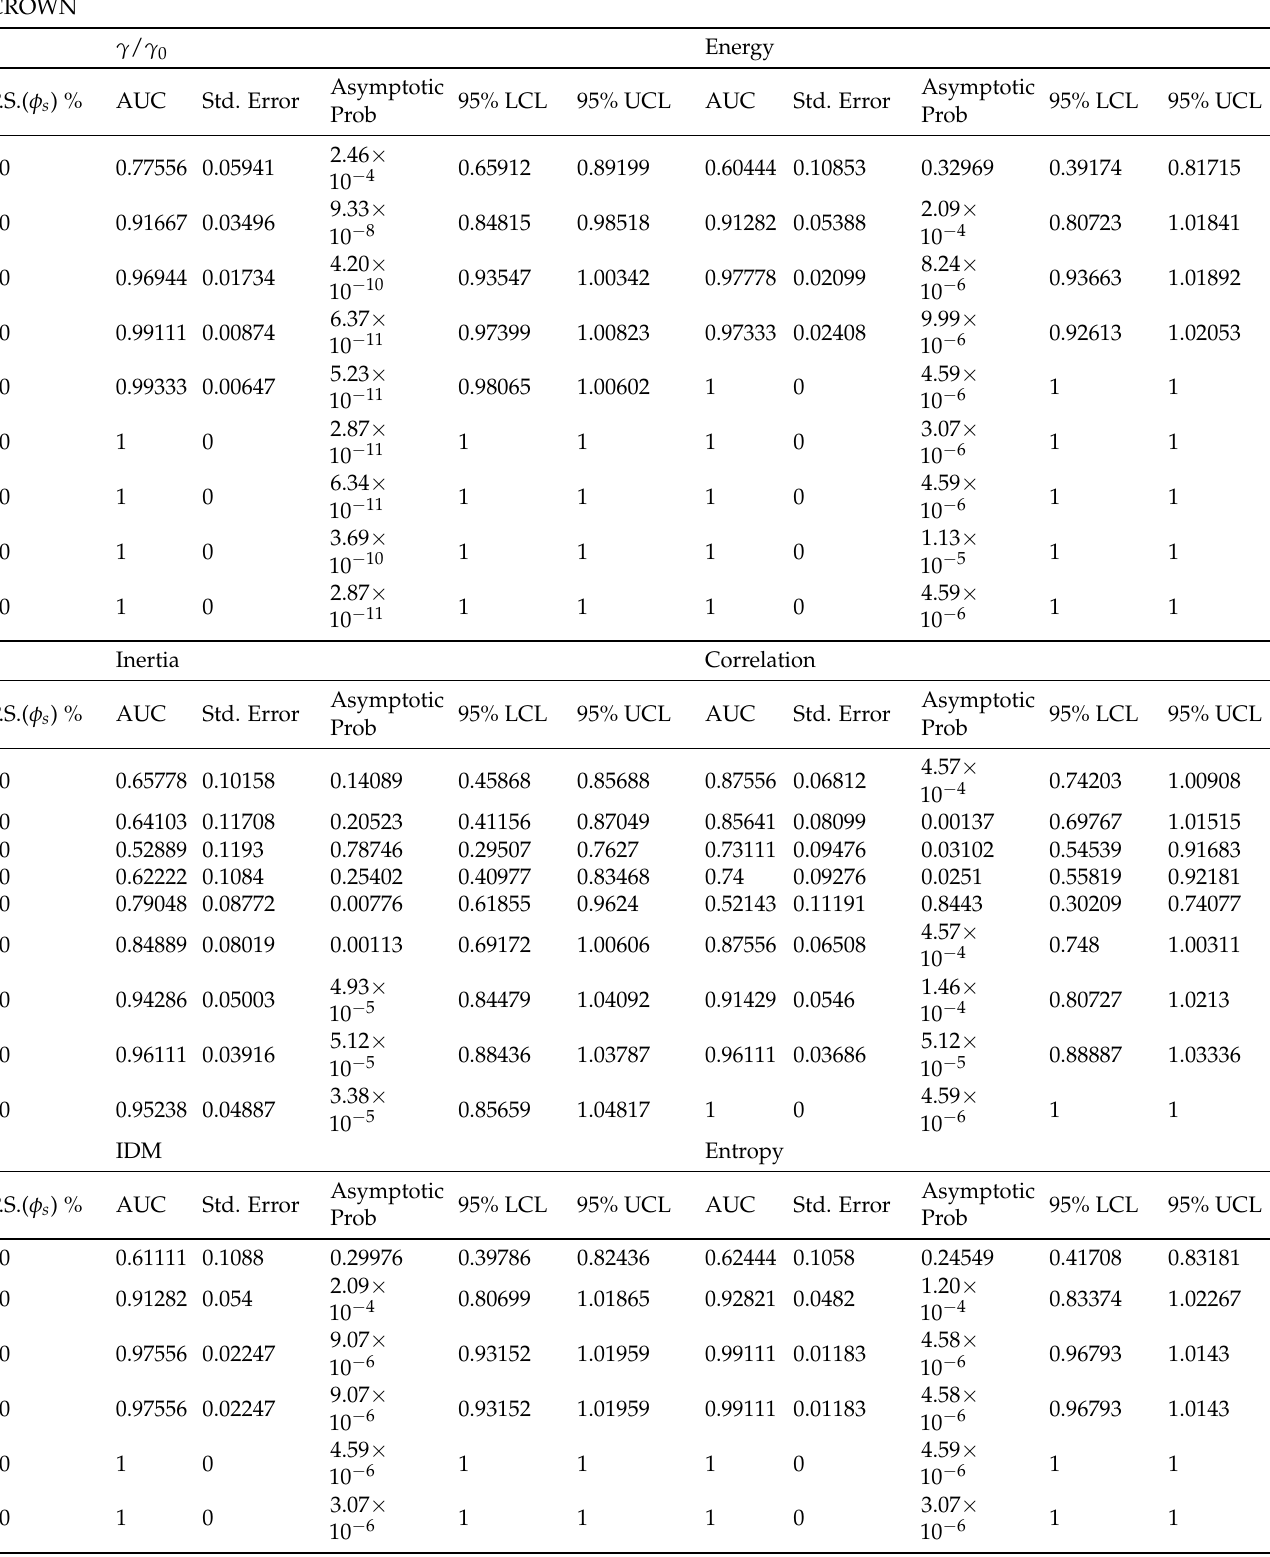
Table 1. Receiver Operated Characteristic (ROC) curves based on texture parameters estimated on different regions of Methotrexate/NaCl stains. Ps = water content (%). Error = standard error. Asym. prob.: asymptotic probability. LCL: the lower confidence limit. UCL: the upper confidence